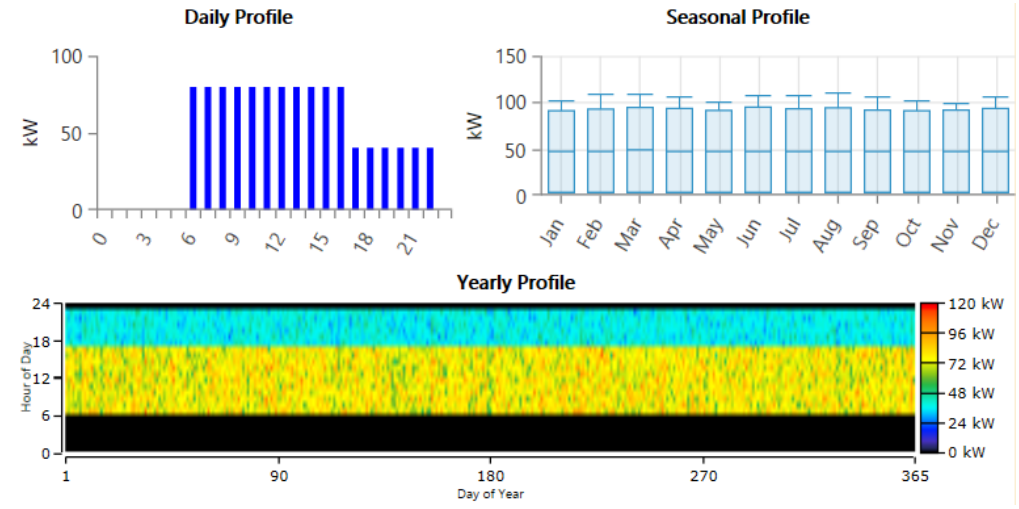
Figure 6. EV charging station system load profile.